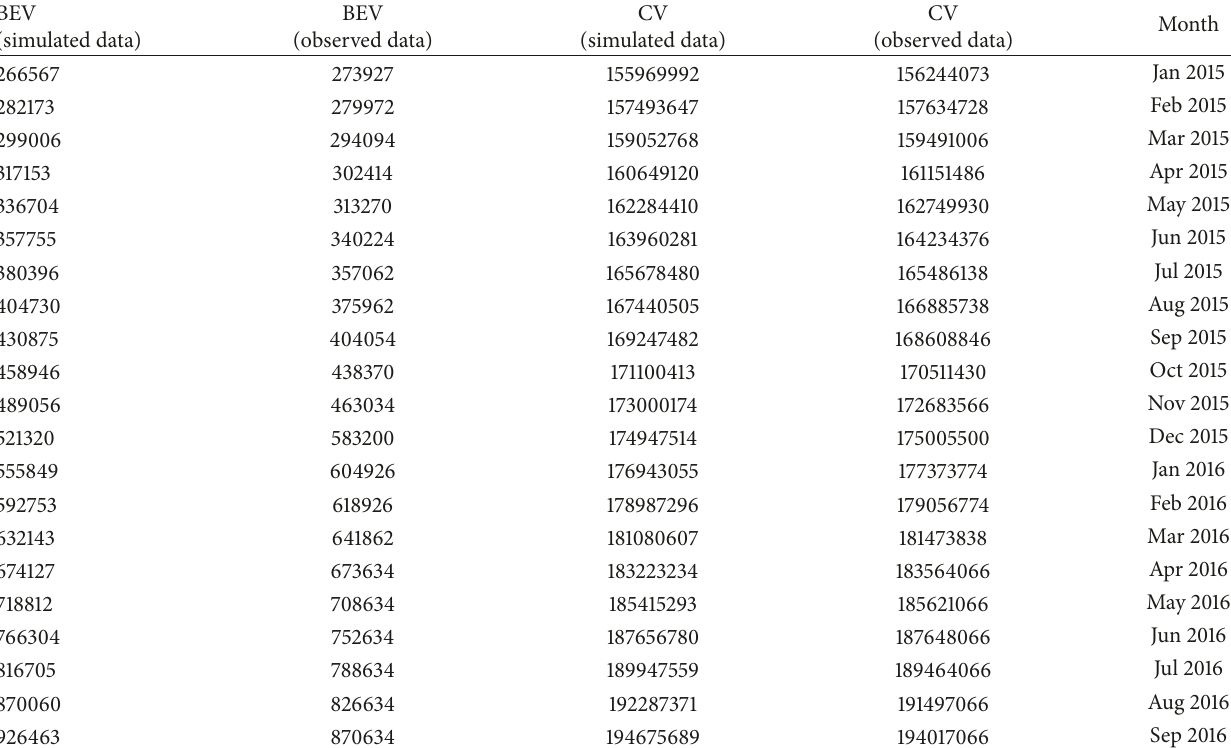
Table 3: Simulated result of BEV and CV based on LV model.